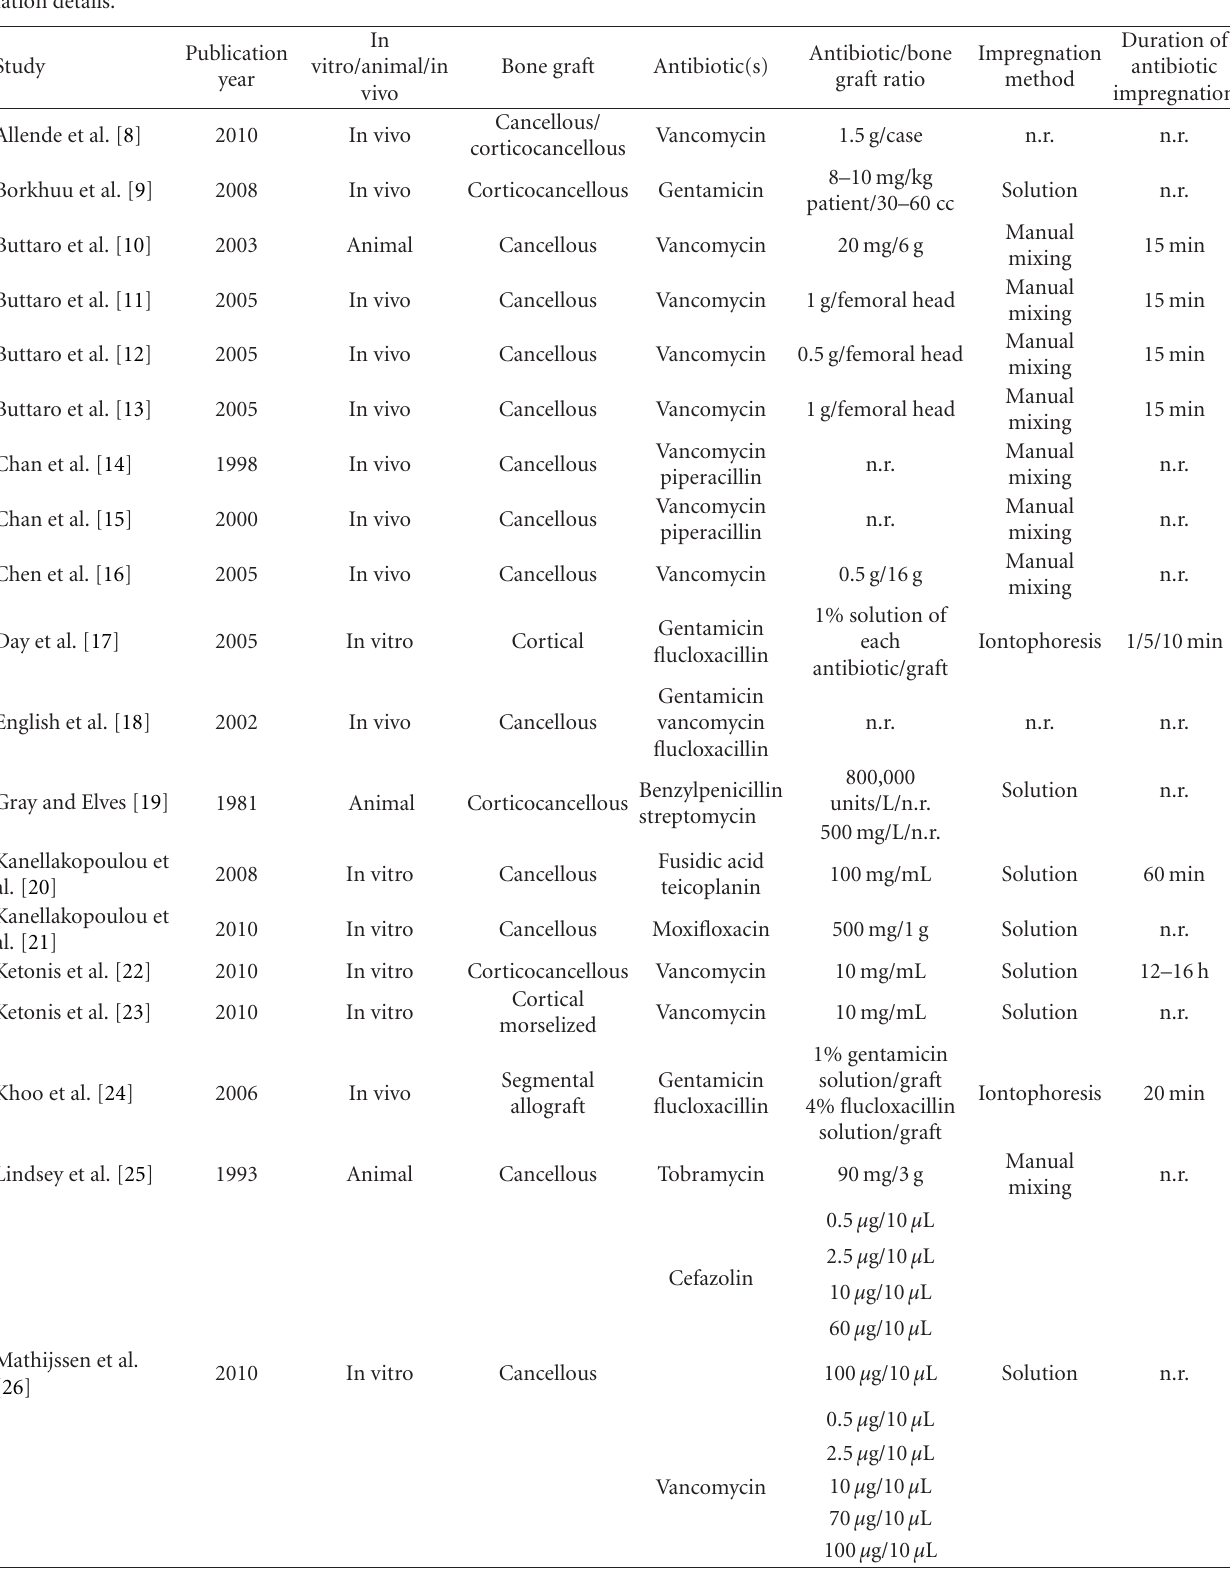
Table 1: Literature review about antibiotic-impregnated bone grafts with specific attention on types of bone graft, antibiotics, and impreg- nation